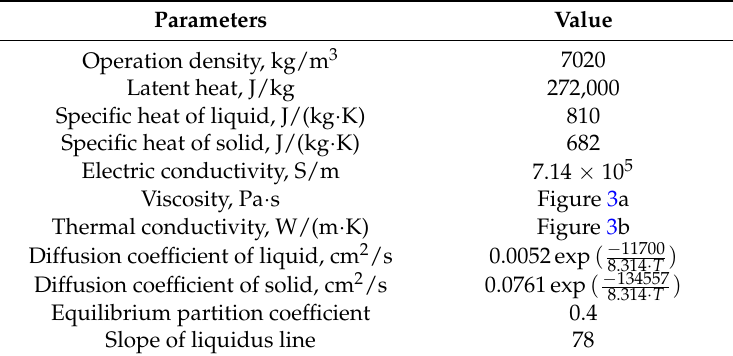
Table 3. Thermo-solutal and physical parameters of U71Mn steel.